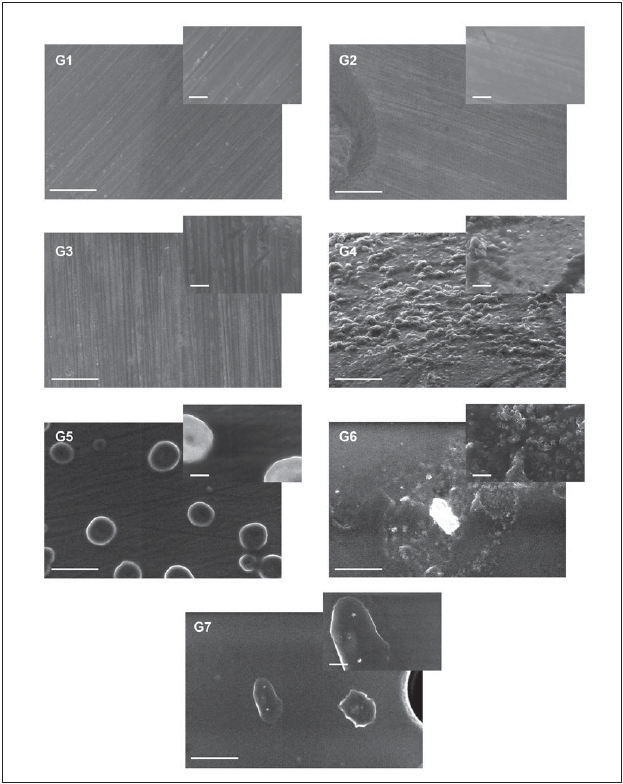
Fig. 1. LV-SEM micrographs of the enamel surfaces representative of all experimental groups. Main micrograph at 500X (bar = 50µm). Micrograph in detail at 2000X (bar = 10µm).